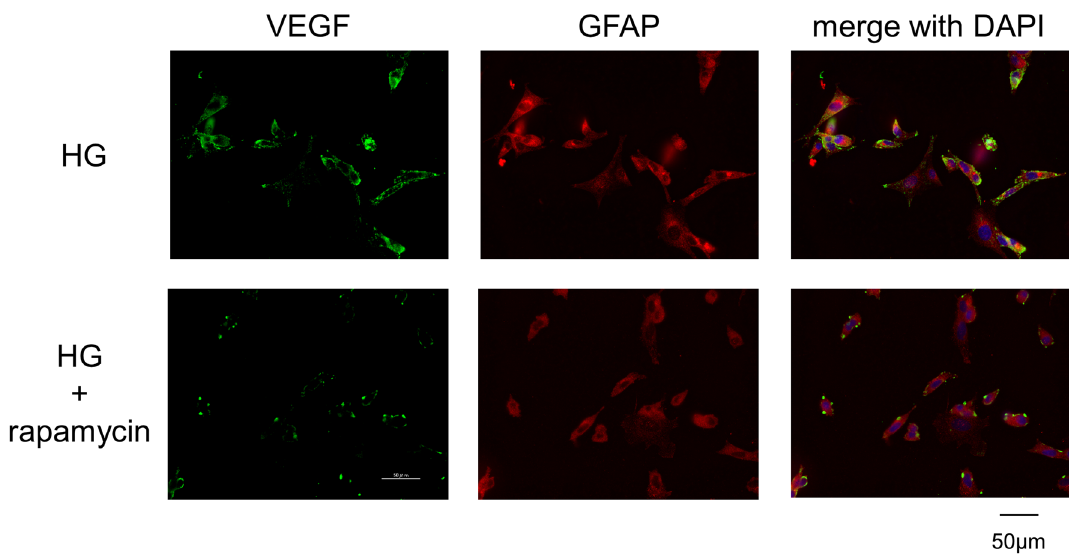
Figure 2. Immunostaining of VEGF and GFAP in TR-MUL5 cells. Expression of VEGF and GFAP in cells cultured in high glucose medium (HG) seemed to be reduced by the mTOR inhibitor rapamycin (HG +